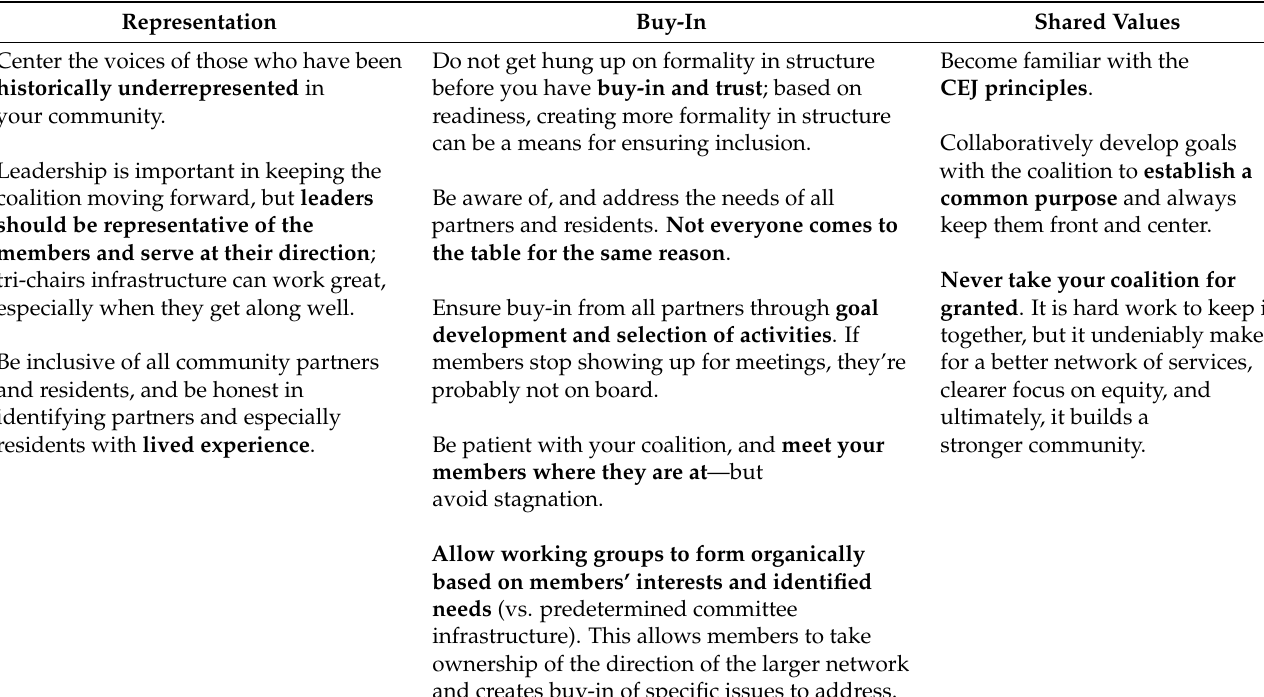
Table 5. Recommendations for coalition-building for equity and